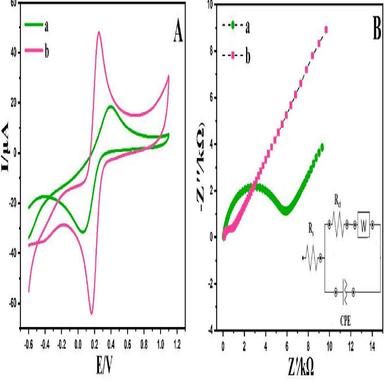
(A) CVs curves and (B) Nyquist semicircle plots of bare GCE (a), and LaNiO3/g-C3N4@RGH/GCE (b) in 5.0 mM 3− /4− in 0.1 M KCl (Rs electrolyte solution resistance, Rct element of interfacial electron transfer resistance, CPE constant phase element, W Warburg impedance resulting from the diffusion of ions).